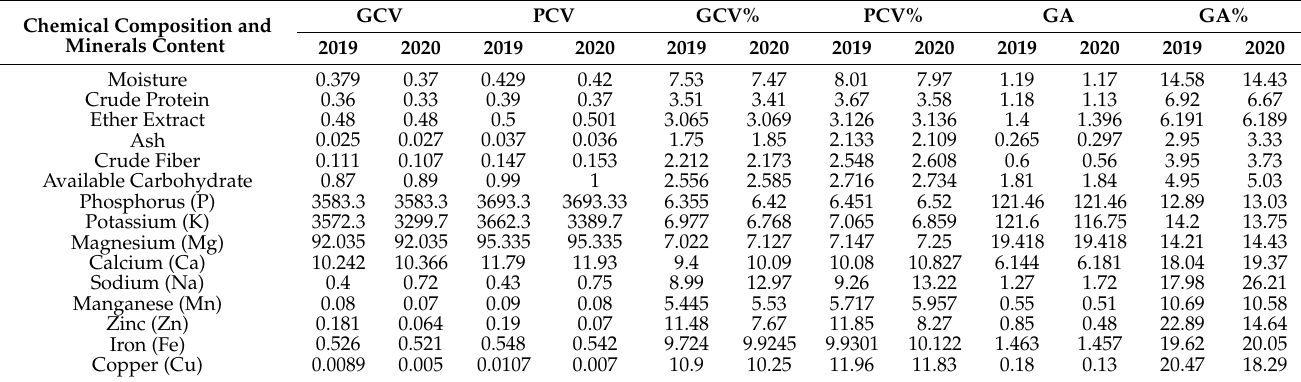
Table 10. Estimates of variability parameters for gross chemical composition (%) and minerals content (mg/100 g) of stabilized rice bran samples of the studied genotypes during the 2019 and 2020 growing seasons.